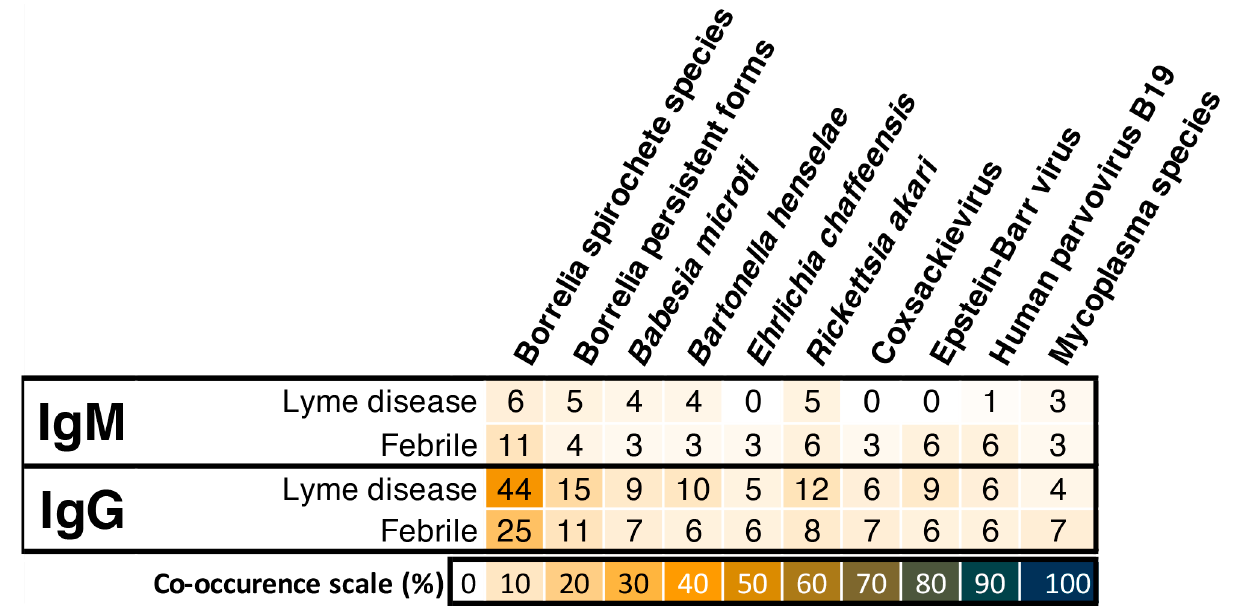
Figure 2. Screening of febrile patients for tick-borne diseases could be a missed opportunity at reducing misdiagnosed and undiagnosed patient cases, as their positive IgM and IgG immune response percentages are similar to the Lyme disease group. Borrelia spirochete species and Borrelia persistent forms refer to Borrelia burgdorferi sensu stricto , Borrelia afzelii , and Borrelia garinii in spirochete and persistent forms, respectively. Similarly, Mycoplasma species refers to Mycoplasma fermentans and Mycoplasma pneumoniae.